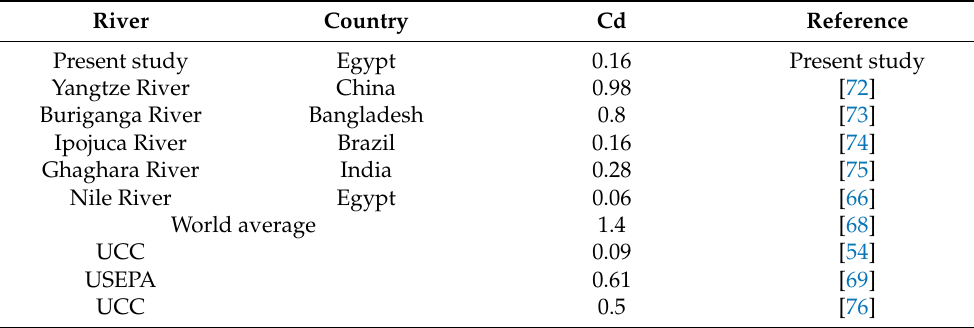
Table 2. Average Cd concentration in the current study (mg kg − 1 ) compared to the average of worldwide rivers in sediments (mg kg − 1 ).